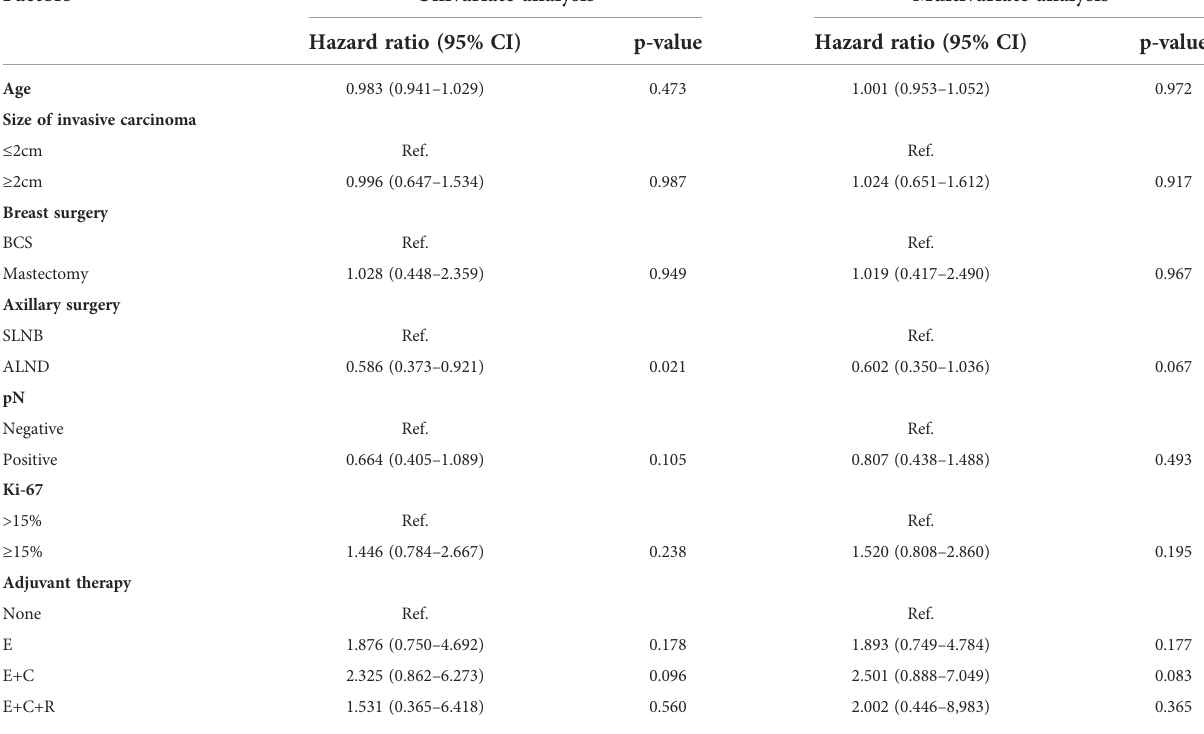
TABLE 4 Univariate and multivariate analysis of RFS among HR+/HER2 − patients.